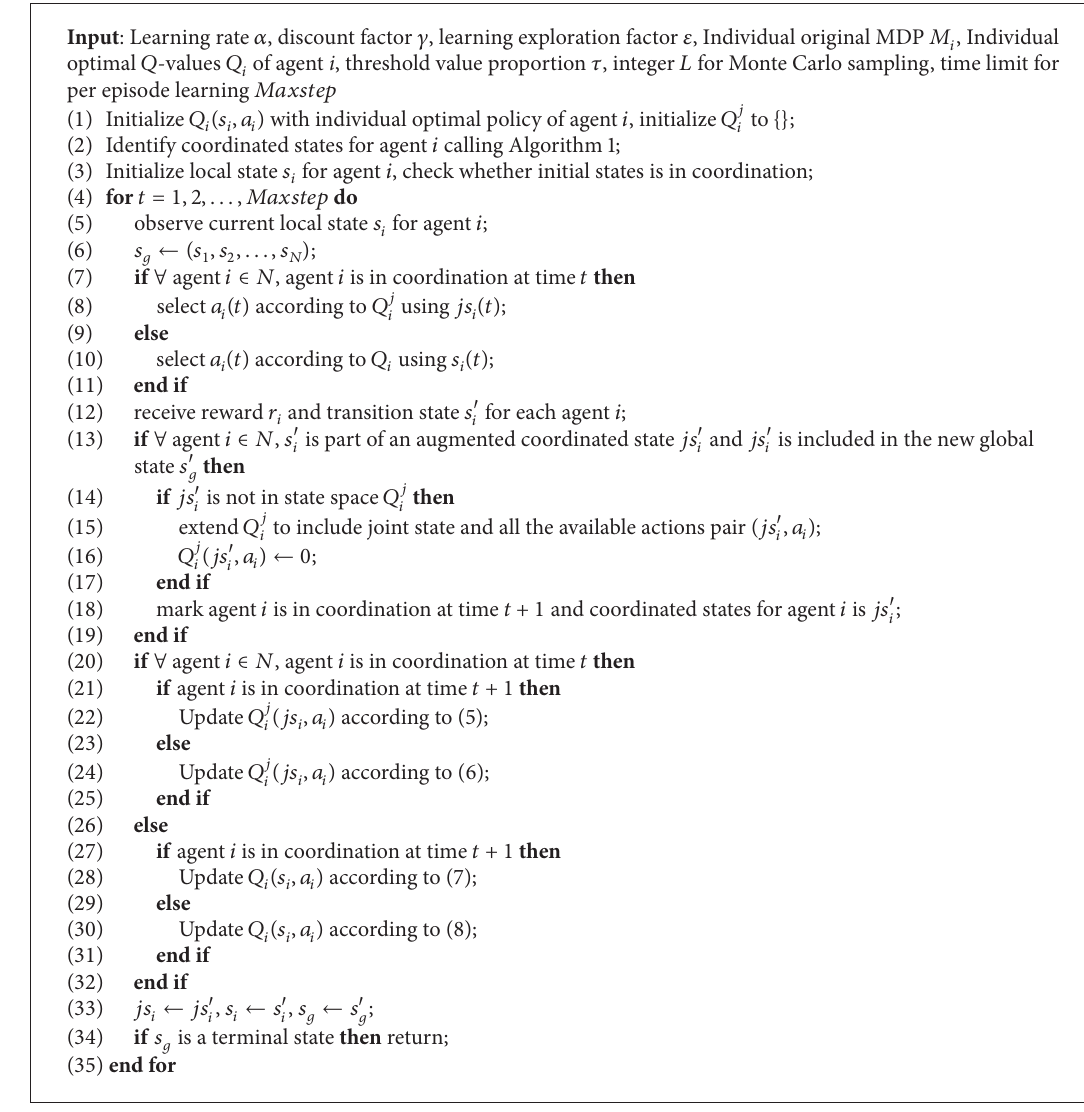
Algorithm 2: Model-based difference degree learning approach for agent 𝑖